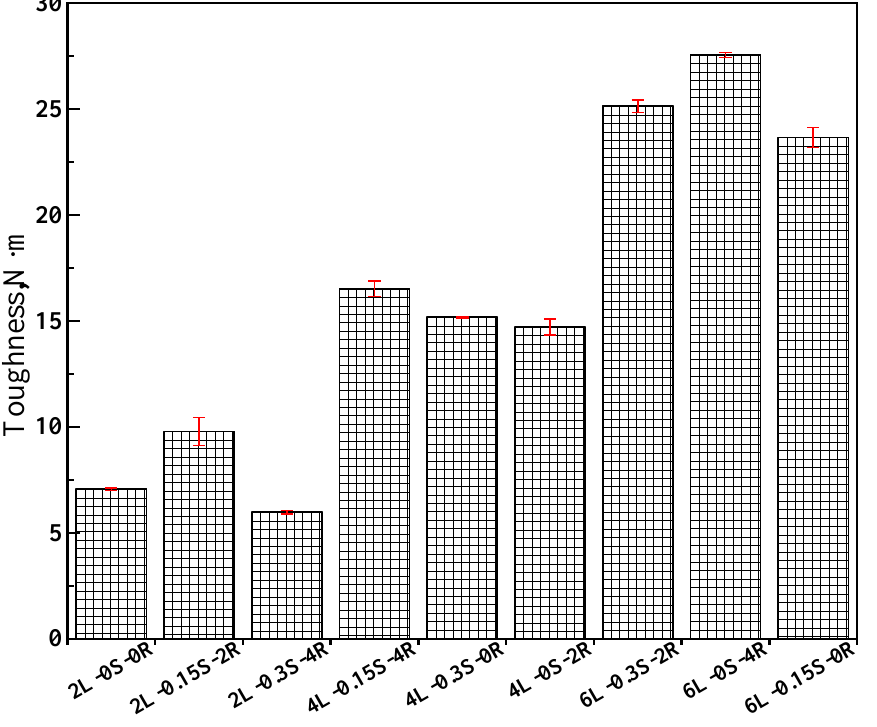
Figure 7. Toughness of all tested binders. Table 7. Orthogonal test